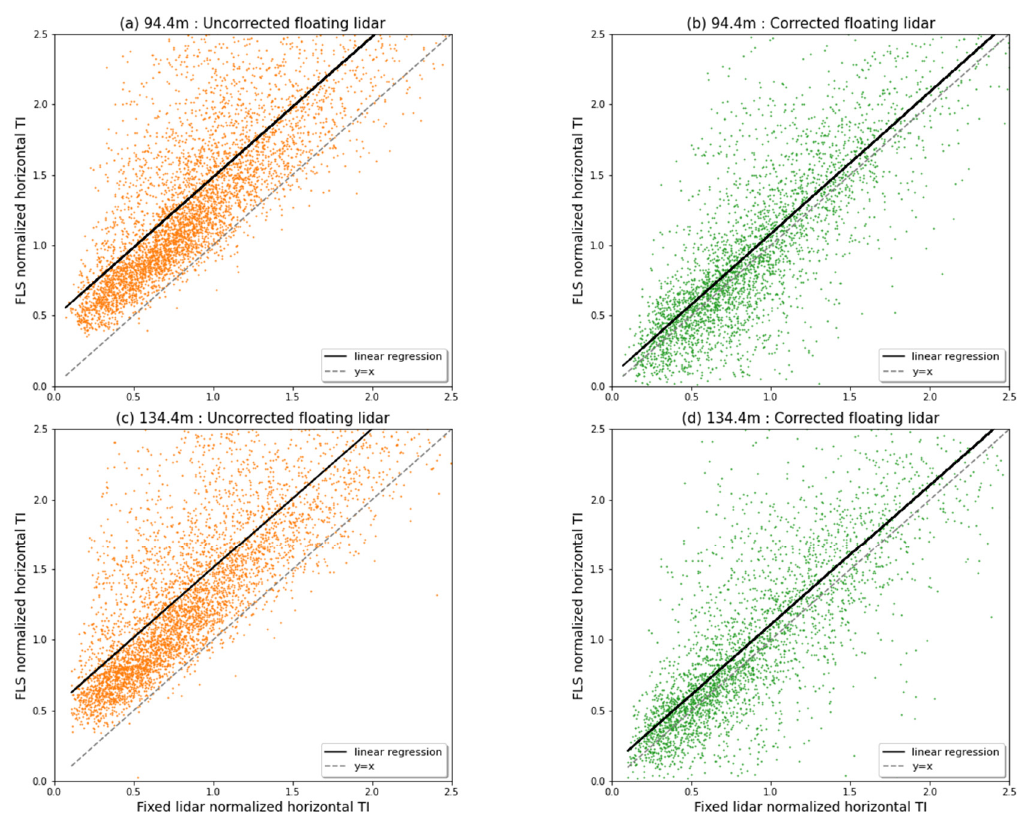
Figure 15. Linear regression of the 10-min turbulence intensity measurement from the uncorrected and corrected floating LIDAR with respect to the fixed LIDAR measurement at two altitudes: 94.4 m and 134.4 m. All ticks are normalized by the fixed LIDAR’s mean TI from all the 10-min samples. ( a , c ) Raw floating LIDAR measurement at the two evaluated altitudes. ( b , d ) Floating LIDAR measurement corrected by the model at the two evaluated altitudes.